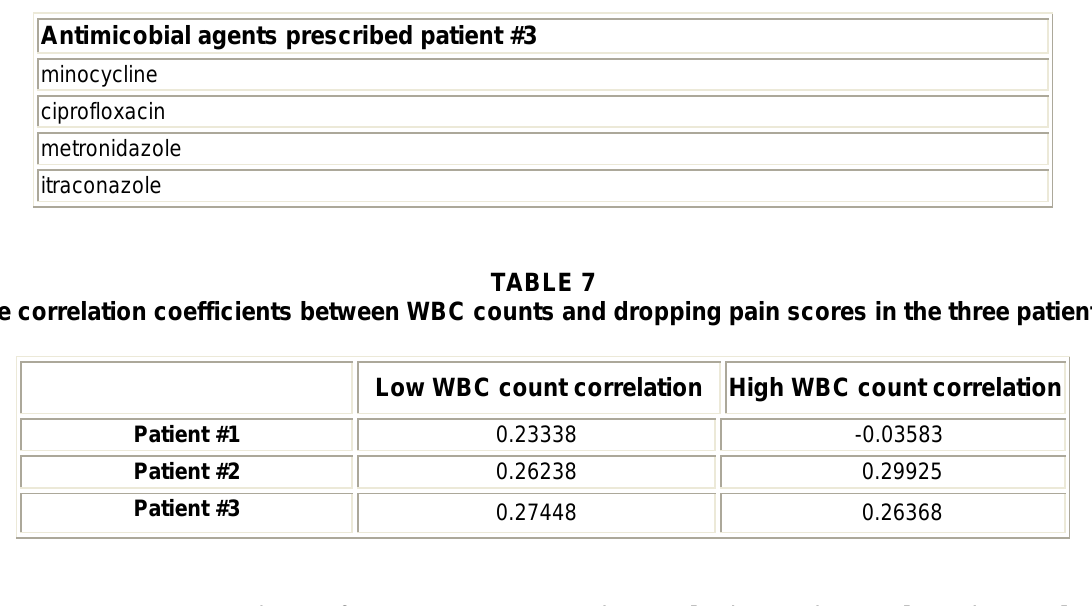
List of all antimicrobial agents prescribed for patient #3.